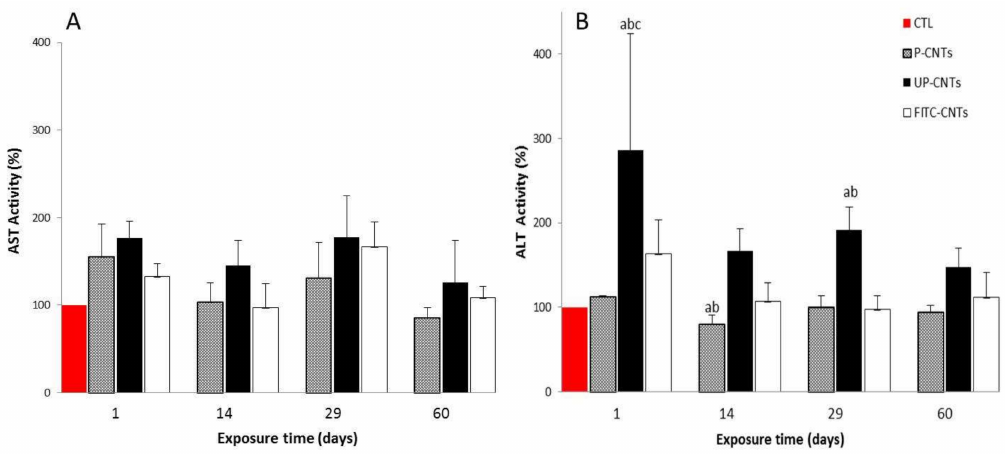
Figure 6. Effect of exposure with different CNTs on the relative activity of AST and ALT. Relative activity of serum aminotransferases in mice exposed to different CNTs at 1, 14, 29, and 60 days post exposure. ( A ) AST and ( B ) ALT activities. Each bar represents the mean ± SE of each group ( n = 4). a: difference with respect to the control ( p < 0.05). b: difference among treatments ( p < 0.05), and c: difference among times post exposure ( p <